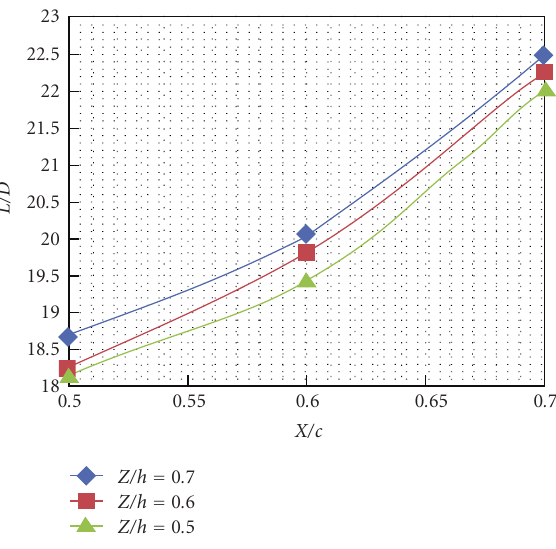
Figure 3: L/D with di ff erent nacelle